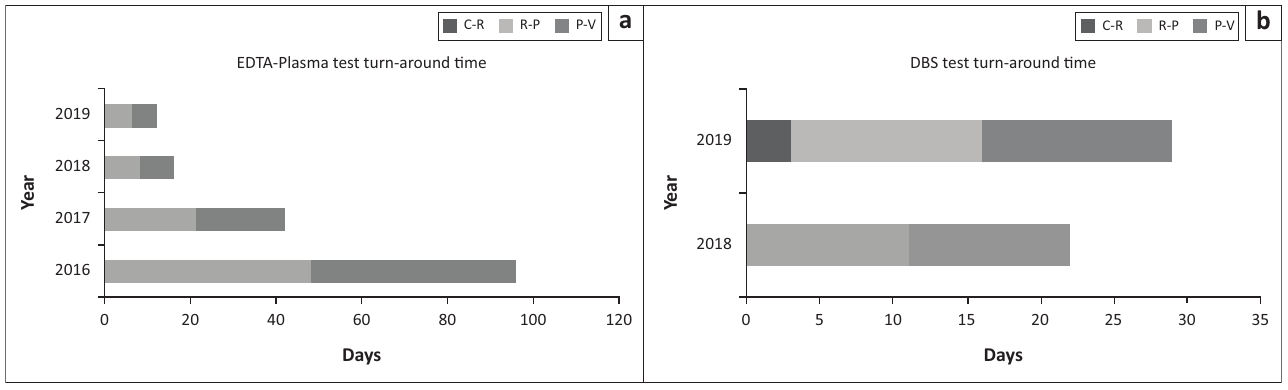
FIGURE 4: Viral load testing turn-around time by sample type and by year that each type of viral load test was used. (a) Ethylenediaminetetraacetic acid plasma 2016–2019; (b) Dried blood spots 2018–2019, in Côte d’Ivoire. Turn-around time is further disaggregated by collection to reception (C-R), reception to processing (R-P), and processing to validation